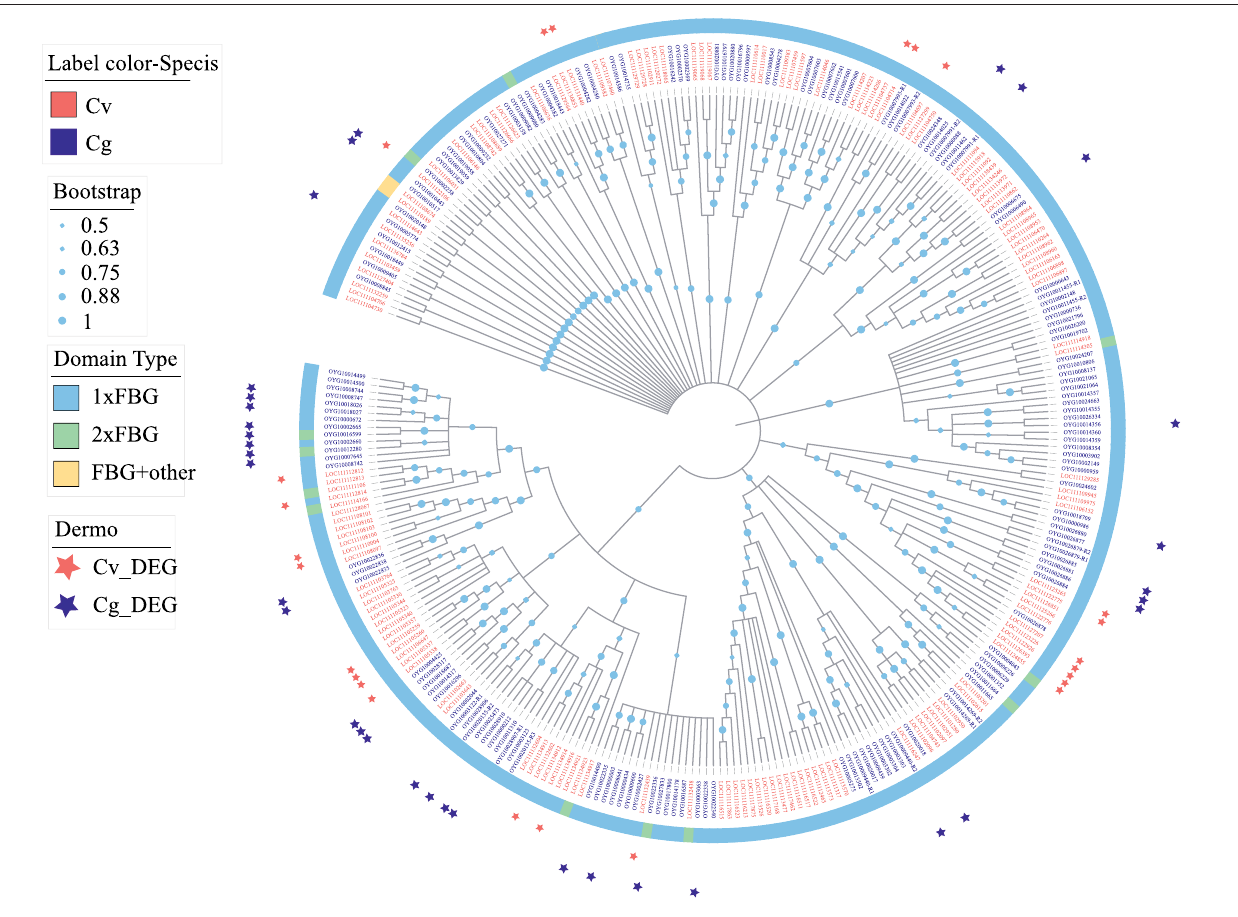
FIGURE8| ExpansionandphylogenyofFBGDCgenefamilyin C.virginica (redfont)and C.gigas (grayfont).Thephylogenetictreeisconstructedwiththemaximum likelihoodmethodshowinglineage-speci fi c expansion ofFBGDC in C. virginica (redfont)and C. gigas (grayfont).Differentcolorbackgroundsrepresent different domain composition types, and the red and gray asterisks represent differentially expressed FBGDCs under P. marinus challenge in C. virginica and C. gigas , respectively.